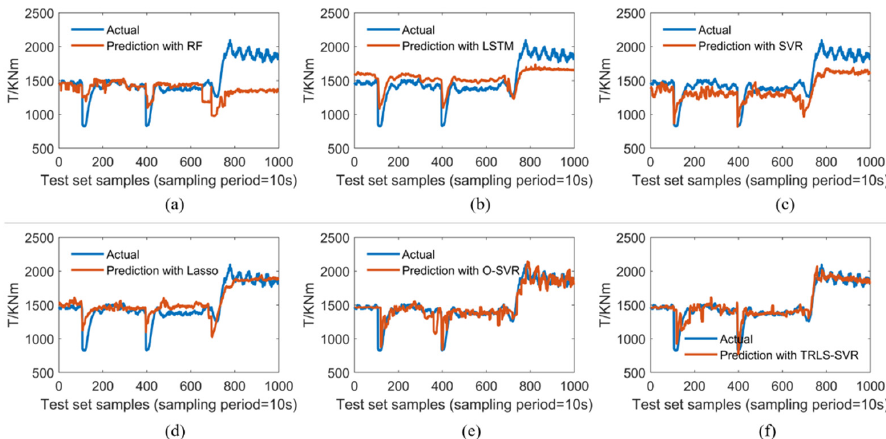
Figure 8. Comparisons between real and predicted cutterhead torque for dataset 4. ( a ) Prediction result of RF. ( b ) Prediction result of LSTM. ( c ) Prediction result of SVR. ( d ) Prediction result of Lasso. ( e ) Prediction result of OSVR. ( f ) Prediction result of